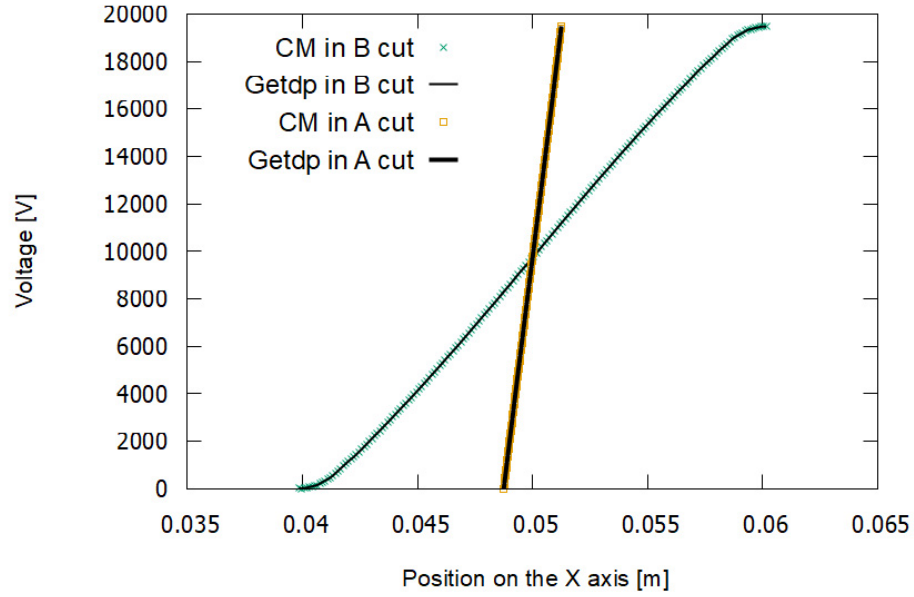
Figure 17. Voltage in cut A (steeper curves) and cut B (curves with lower slope) for experiment E3. The dielectric breakdown voltage is 19,488 V.